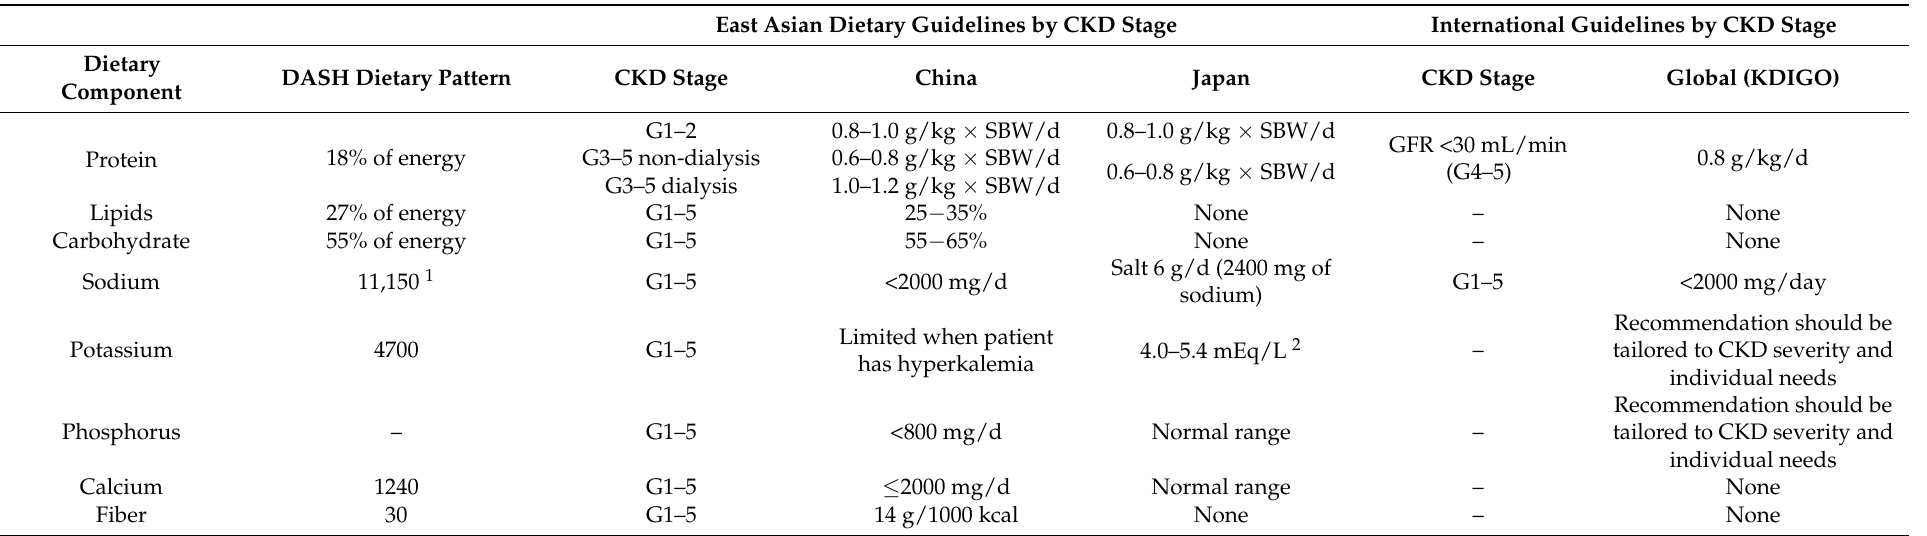
Table 3. Comparison of the DASH diet to global and East Asian chronic kidney disease (CKD) dietary guidelines 1